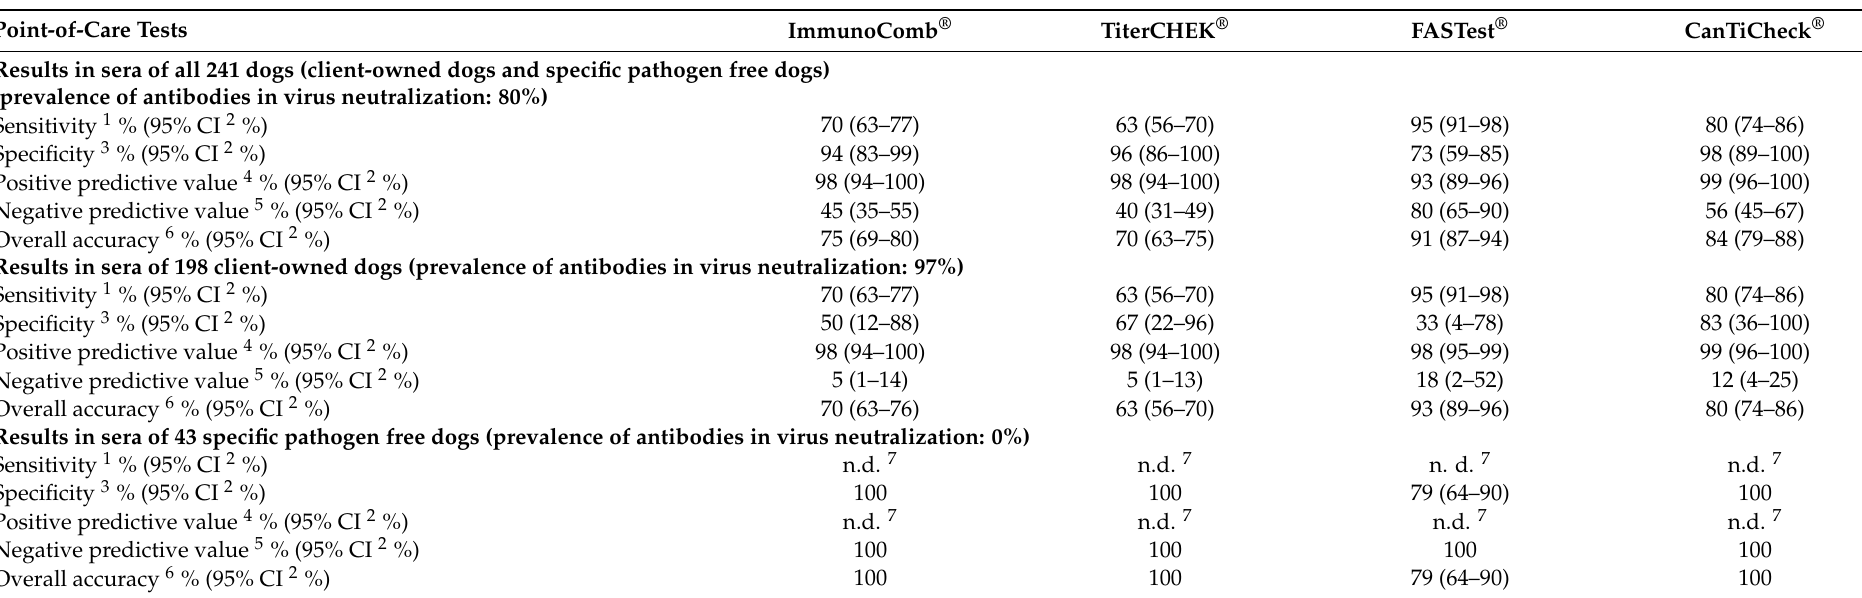
Table 4. Performance parameters of the four point-of-care tests to detect antibodies against canine parvovirus in all 241 dogs, in 198 client-owned dogs, and in 43 specific pathogen-free dogs, based on the results given in Table 1: sensitivity, specificity, positive predictive value, and negative predictive value, as well as overall accuracy, were calculated by using virus neutralization (VN) as the reference standard (considering a cutoff point of ≥ 10 as positive), at a given antibody prevalence of 80% in VN in the sera of all dogs, 97% in the sera of client-owned dogs, and 0% in the sera of specific pathogen-free